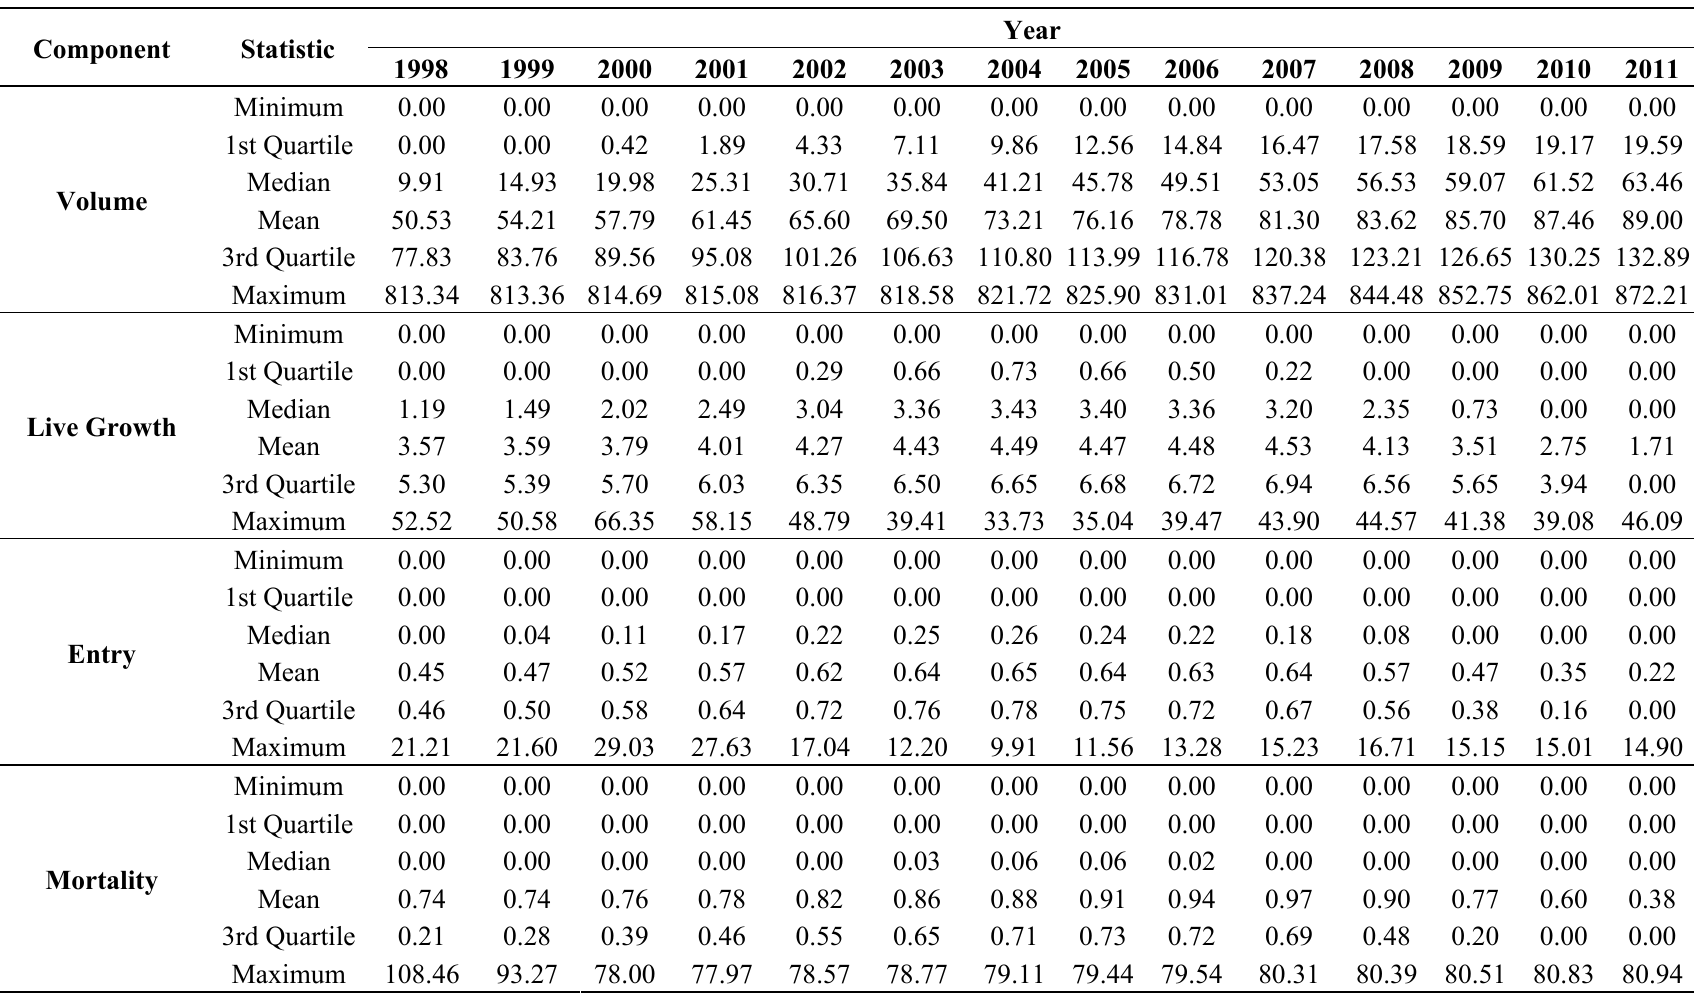
Table 1. Distribution statistics for Population